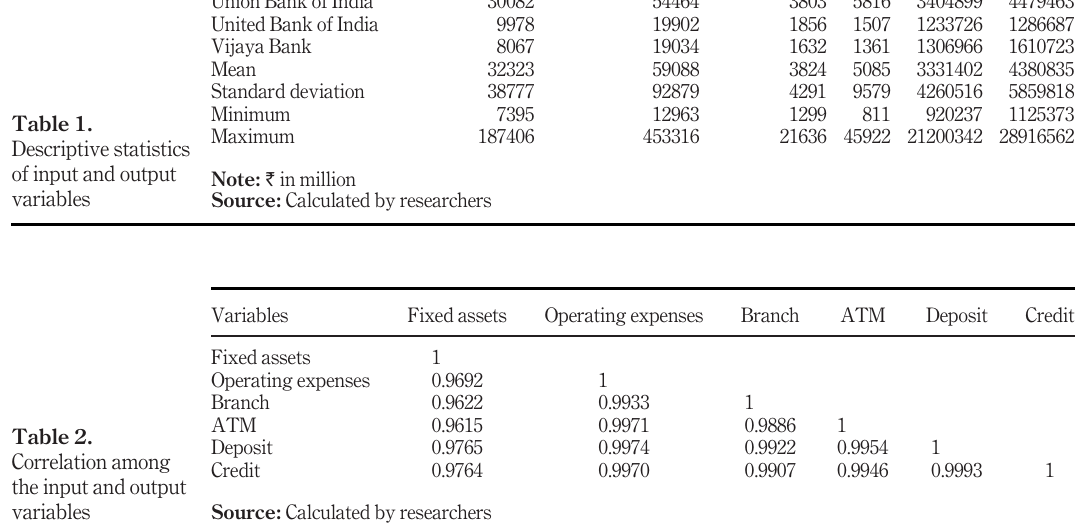
Table 2. Correlation among the input and output variables